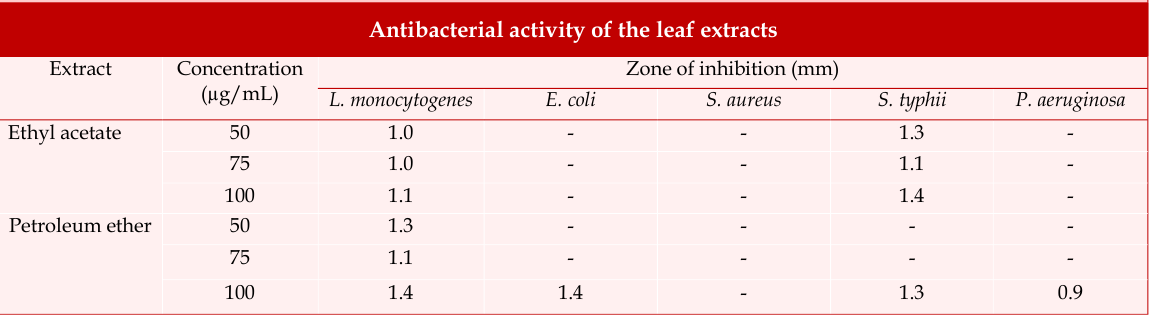
Antibacterial activity of the leaf